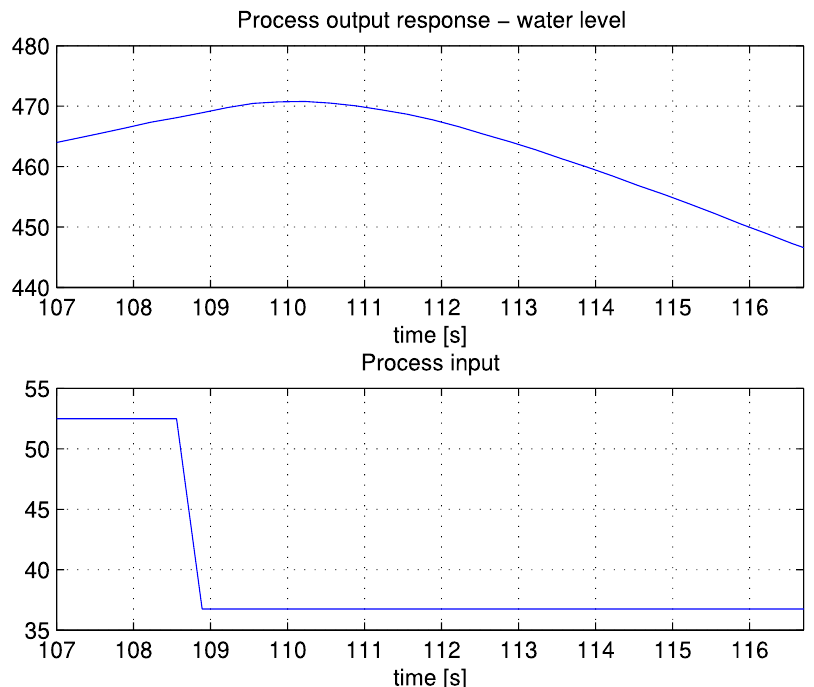
Figure 21. Process input (voltage on pump in %) and output (water level in mm multiplied by a factor of 2) signals during manual experiment on hydraulic process.